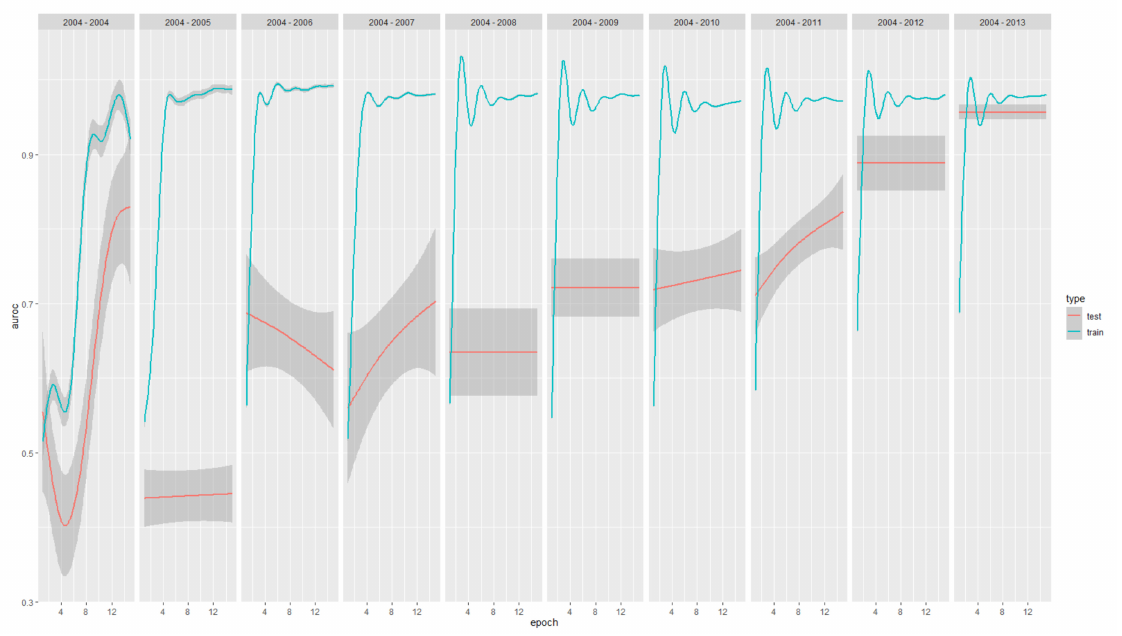
Figure 3. AUC-ROC (y-axis) performance progression across epochs of training (x-axes) and model years(panels from 2004 to 2004–2013, from left to right) for both the train (green) and test (red). In total, 95% CI are reported as shadows.